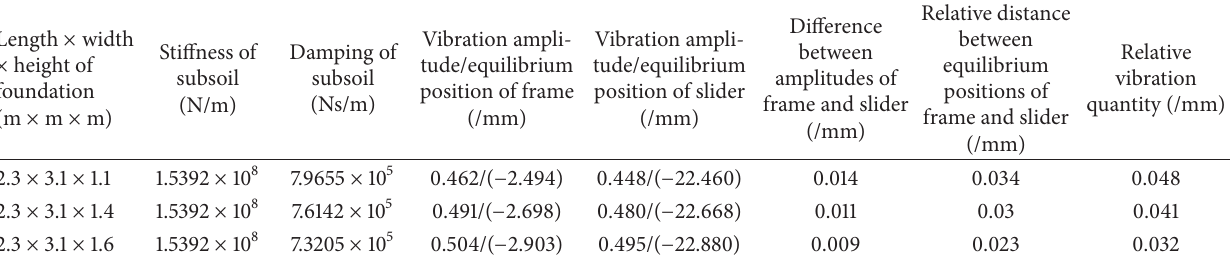
Table 8: Vibration quantity of the punching press for a series of foundations with the same length and width. Length × width × height of